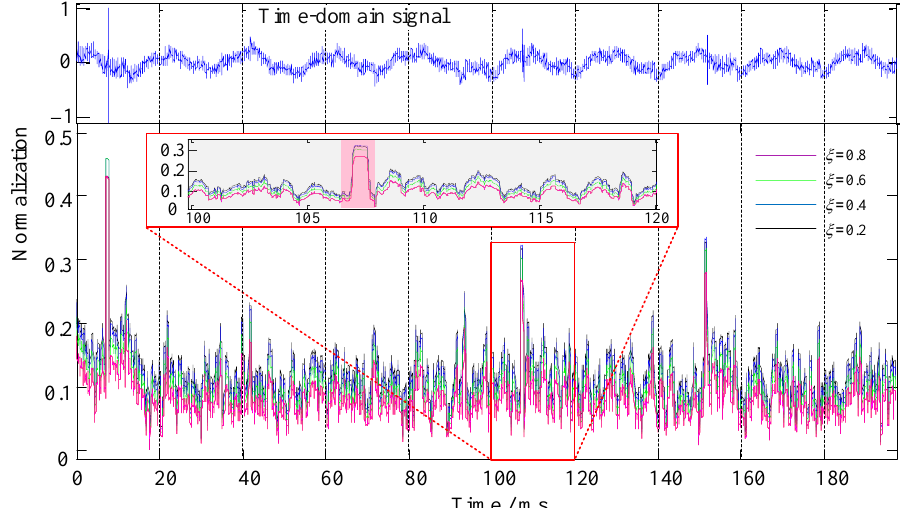
Figure 12. Recognition performance of ξ in the aquaculture engineering application experiment, where λ = 2.